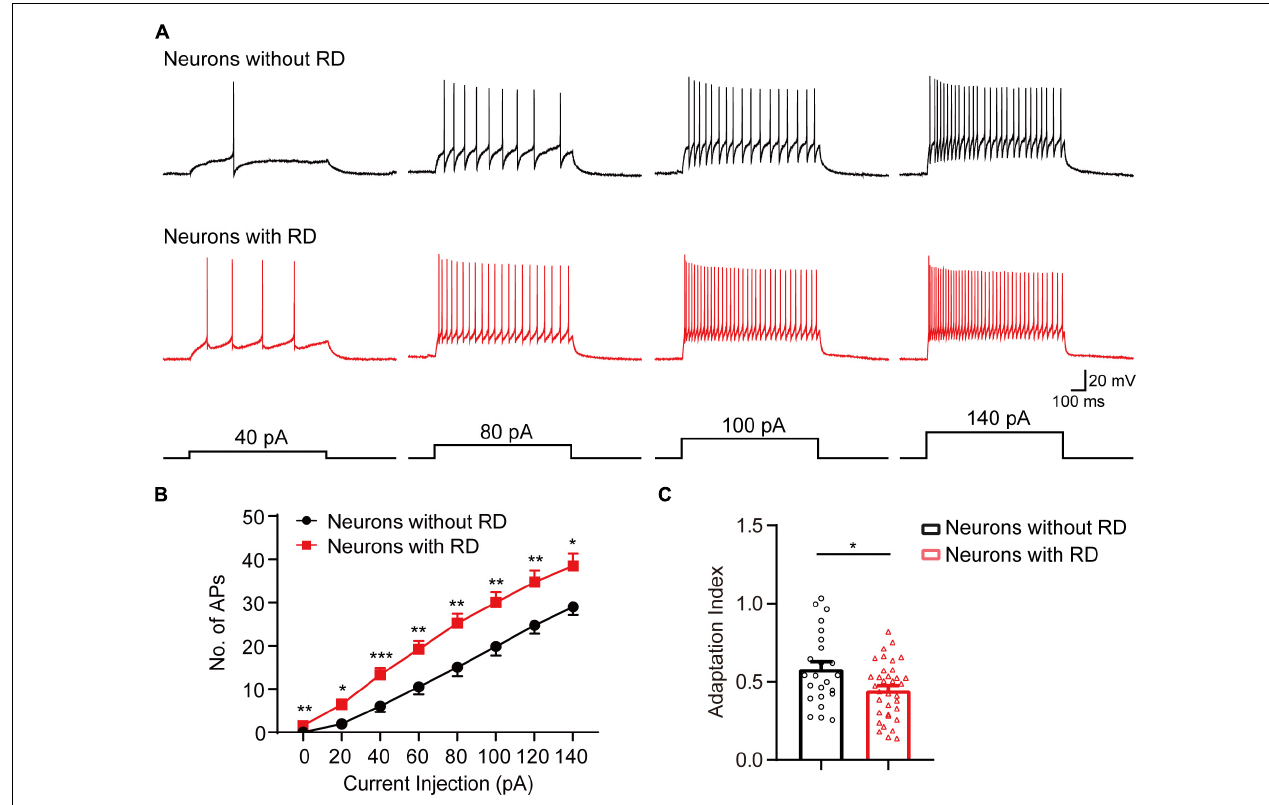
FIGURE 2 | SG neurons with RD that have a tonic-firing pattern exhibit elevated spike frequencies. (A) Representative current-clamp traces showing the responses of SG neurons without (black) or with (red) RD to the indicated depolarizing currents of 40, 80, 100, and 140 pA. (B) Population data showing the number of spikes of SG neurons expressing or lacking RD with a tonic-firing pattern. (C) Summary bar graphs showing that neurons with RD exhibited an elevated spike-frequency adaptation. RD, rebound depolarization; AP, action potential. * p < 0.05, ** p < 0.01, *** p < 0.001. TABLE 2 | Primary afferent input onto SG neurons with or without RD. Neurons without RD ( n =